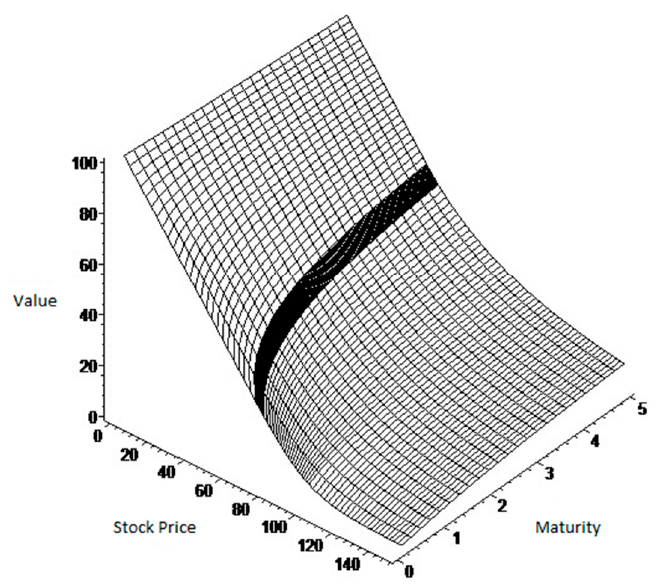
Figure 1. American put option as a function of S and τ . The values of the parameters underlying the construction of this figure are as follows: n , the number of time intervals is 2; r , the interest rate is 0.06; σ , the volatility of the stock price is 0.4; K , the strike price is 100; and φ , the value of constant dividends is 1.6.